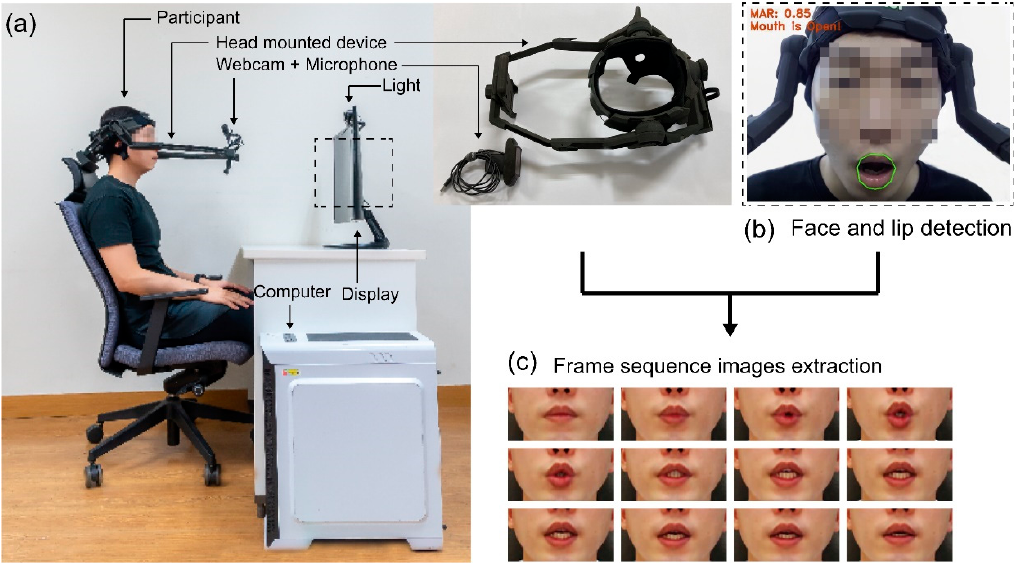
Figure 7. Data-recording environment and image extraction procedure: ( a ) Data-recording environment; ( b ) during data collection, the participant’s face information is visible to the camera, and the green line demarcates the lip detection area; ( c ) frame sequence images extracted from the acquired video.